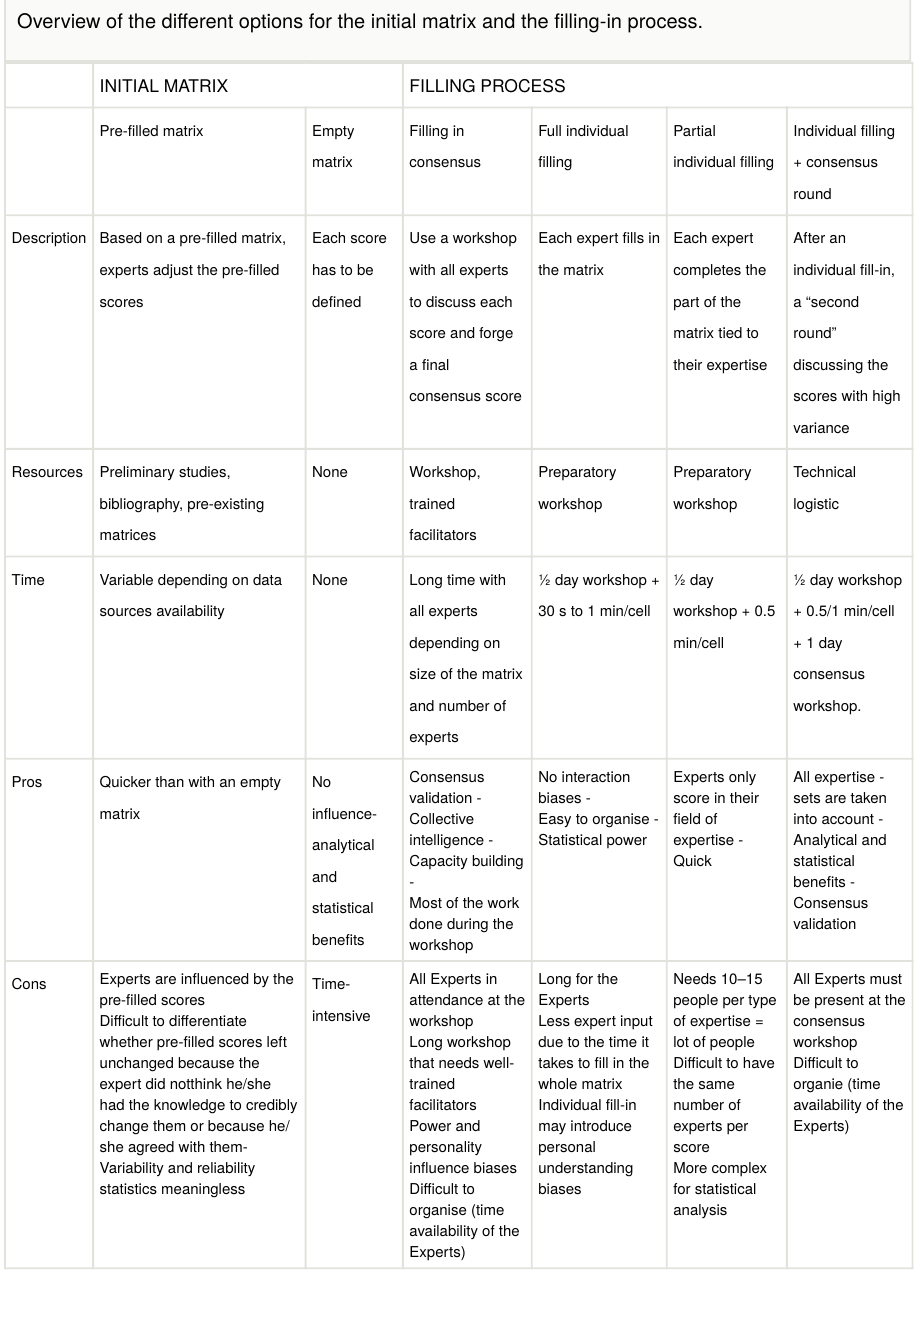
Table 1. Overview of the di ff erent options for the initial matrix and the fi INITIAL MATRIX Pre- fi lled matrix